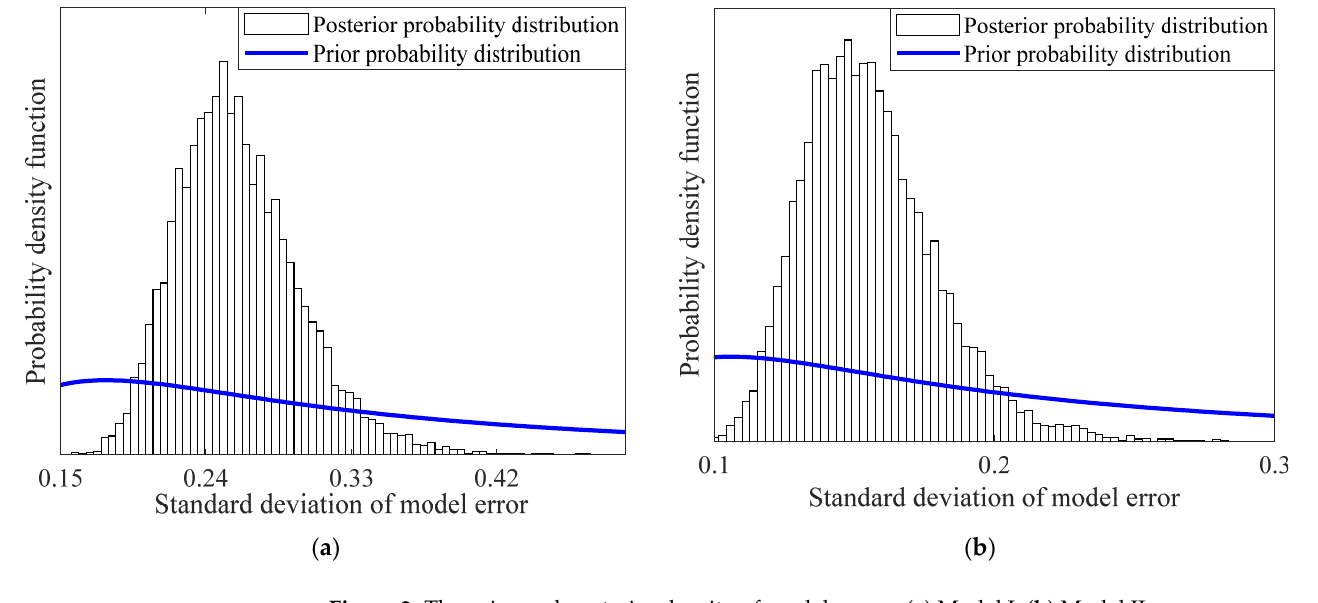
Figure 2. The prior and posterior density of model errors. ( a ) Model I. ( b ) Model II.